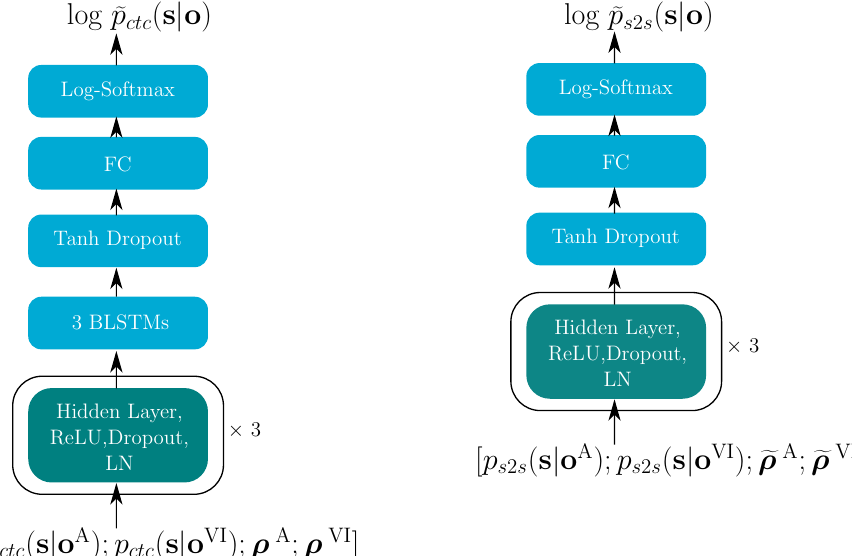
Figure 7. DFN ctc ( left ) and DFN s 2 s ( right ). The turquoise blocks indicate the successively repeated